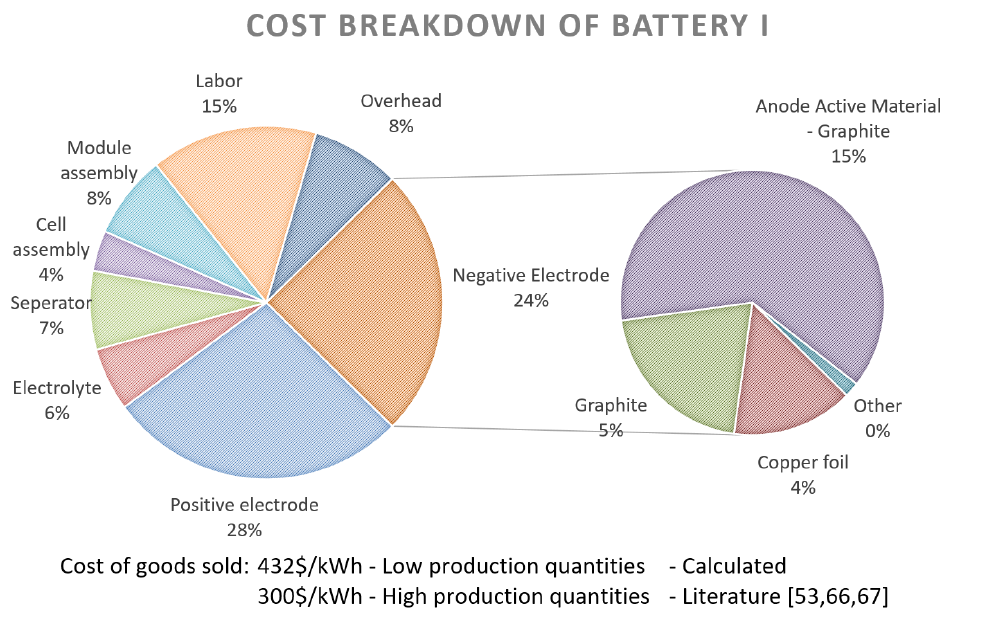
Figure 6. Cost breakdown of battery I with a special focus on the anode